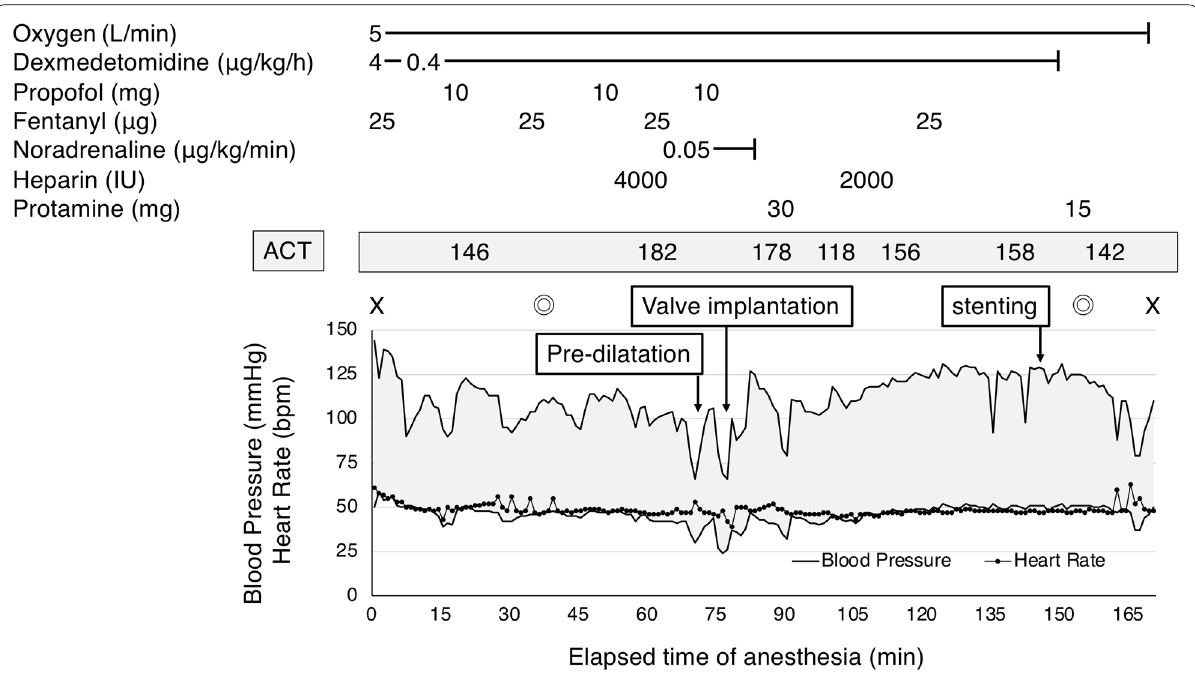
Fig. 1 Anesthesia record. ACT, activated clotting time; X, start and end of anesthesia; ◎ , start and end of